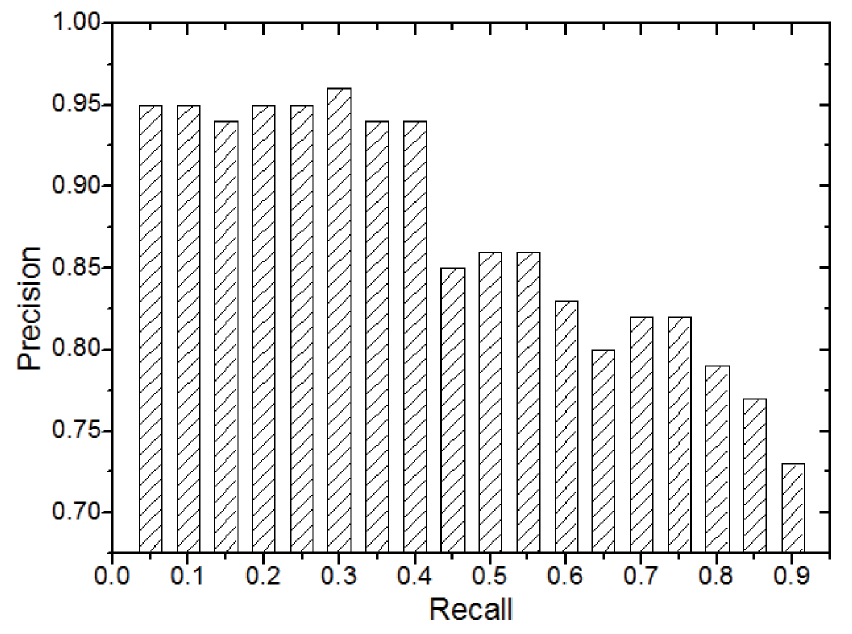
Fig 11. Retrieval